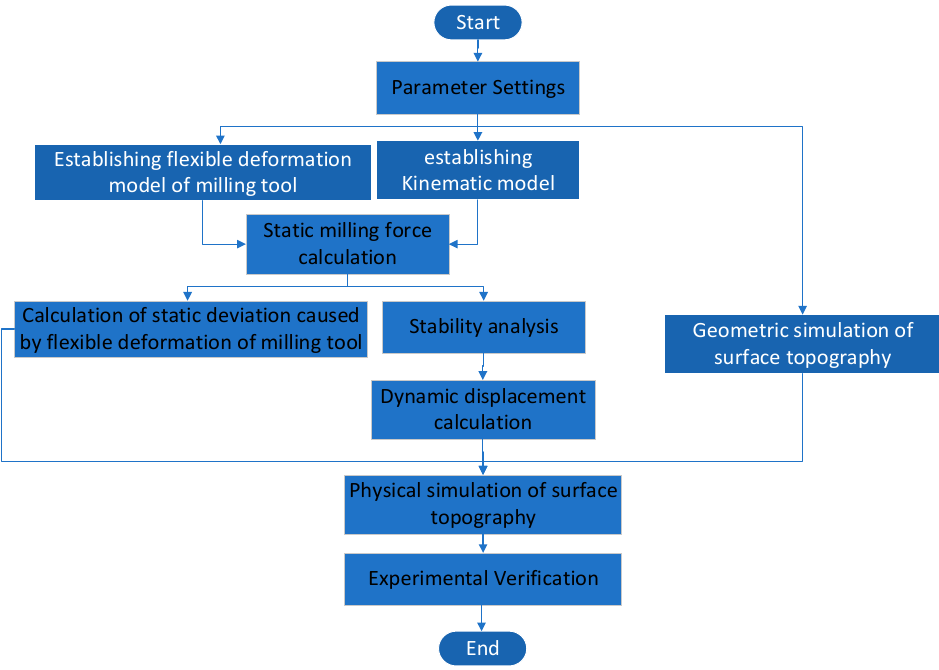
Figure 11. Physical simulation flow of milling surface topography of ultra-high strength steel.